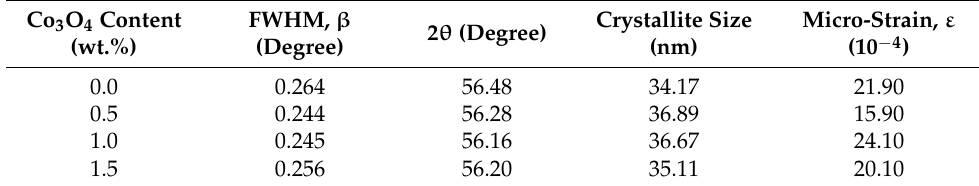
Table 4. Variation of FWHM value, crystallite size and micro-strain ( ε ) of Co-doped ZnO-BaTiO 3 varistor ceramics with different